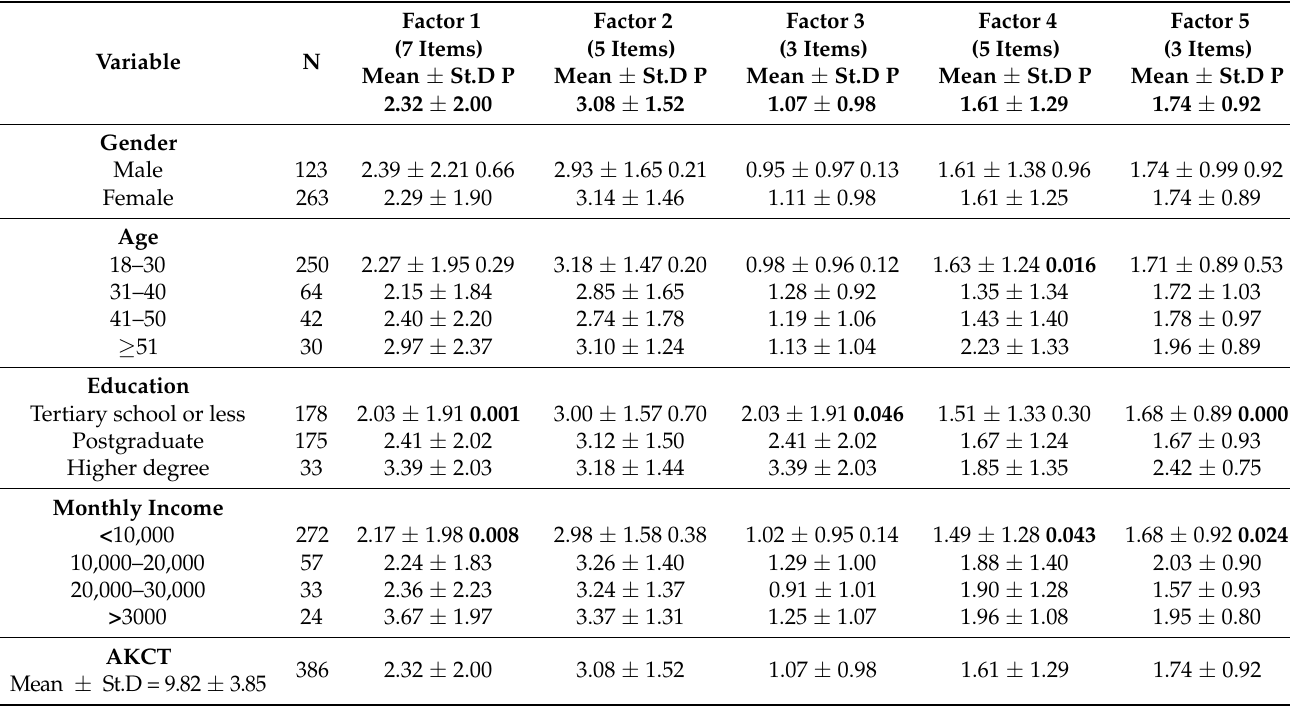
Table 4. Comparisons of factor scores over demographic